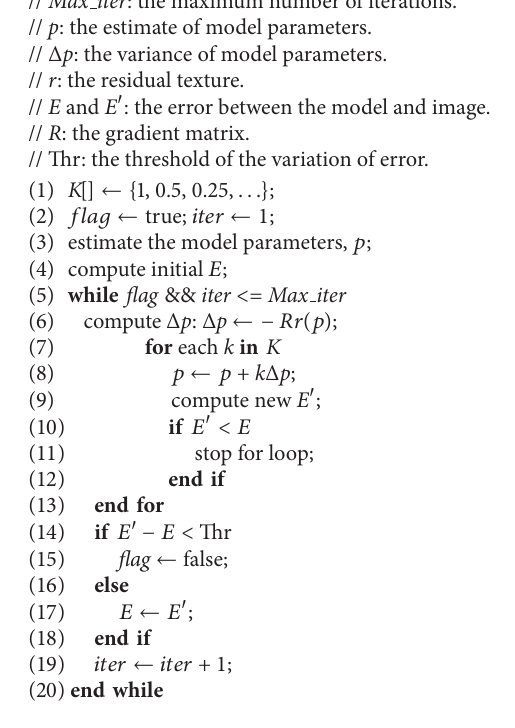
Algorithm 1: CPU-based AAM fitting